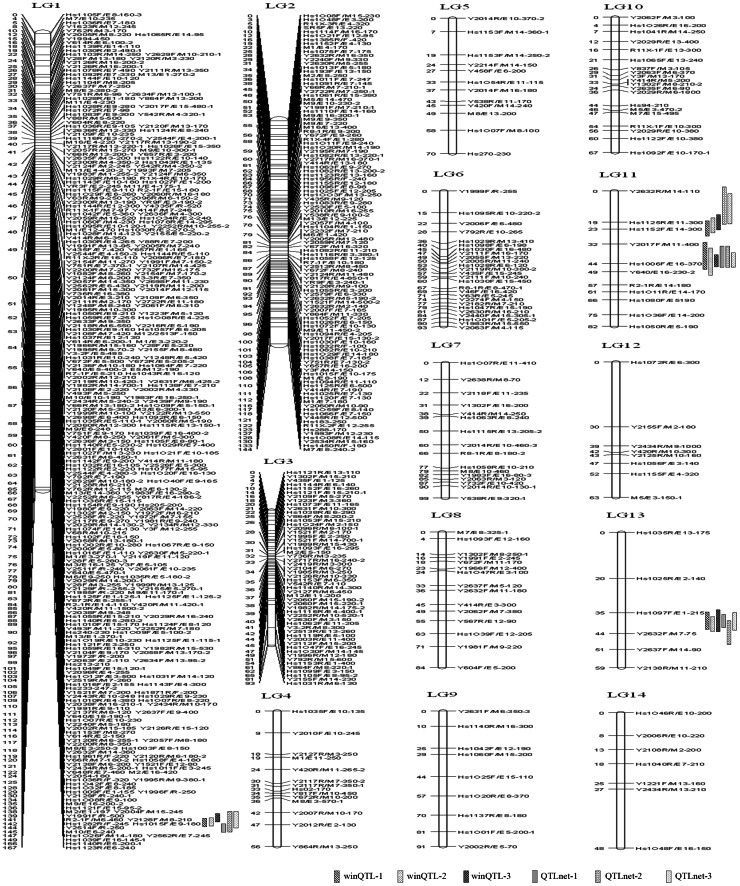
Distribution of QTLs for sesame seed color trait on our seame high-density genetic linkage map.653 marker loci were distributed across the 14 linkage groups of our high-density genetic linkage map at an LOD threshold of 6.0. The cM distance of markers is shown on the left side of each LG. The name, amplicant length (bp) and band number of each marker are shown on the right side of each linkage group. An LOD peak value of >2.5 was considered to indicated a significant QTL interval. The four QTLs identified using two programs are designated as follows: winQTL-1, winQTL-2 and winQTL-3 represent the QTL loci from the F2 population and F3 families (Yuanyang) and F3 families (Pingyu), respectively using the winQTLCart program. QTLnet-1, QTLnet-2 and QTLnet-3 represent the QTL loci from the F2 and F3 family (Yuanyang) and F3 family (Pingyu), respectively, using networks program.